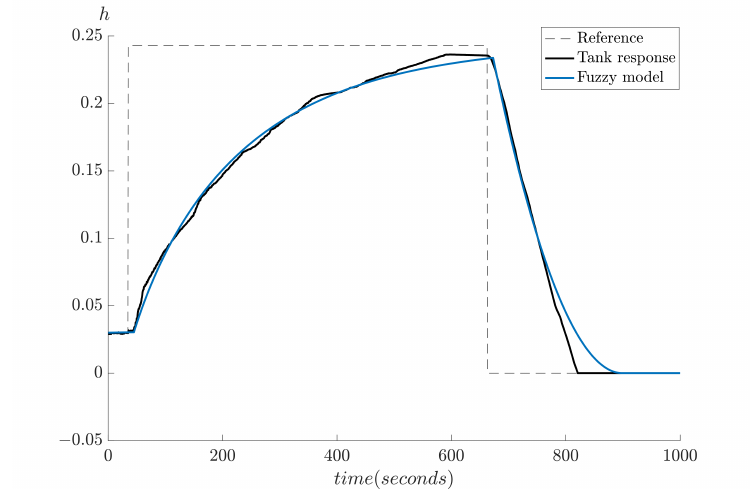
Figure 22. Dynamical evolution of the tank and fuzzy